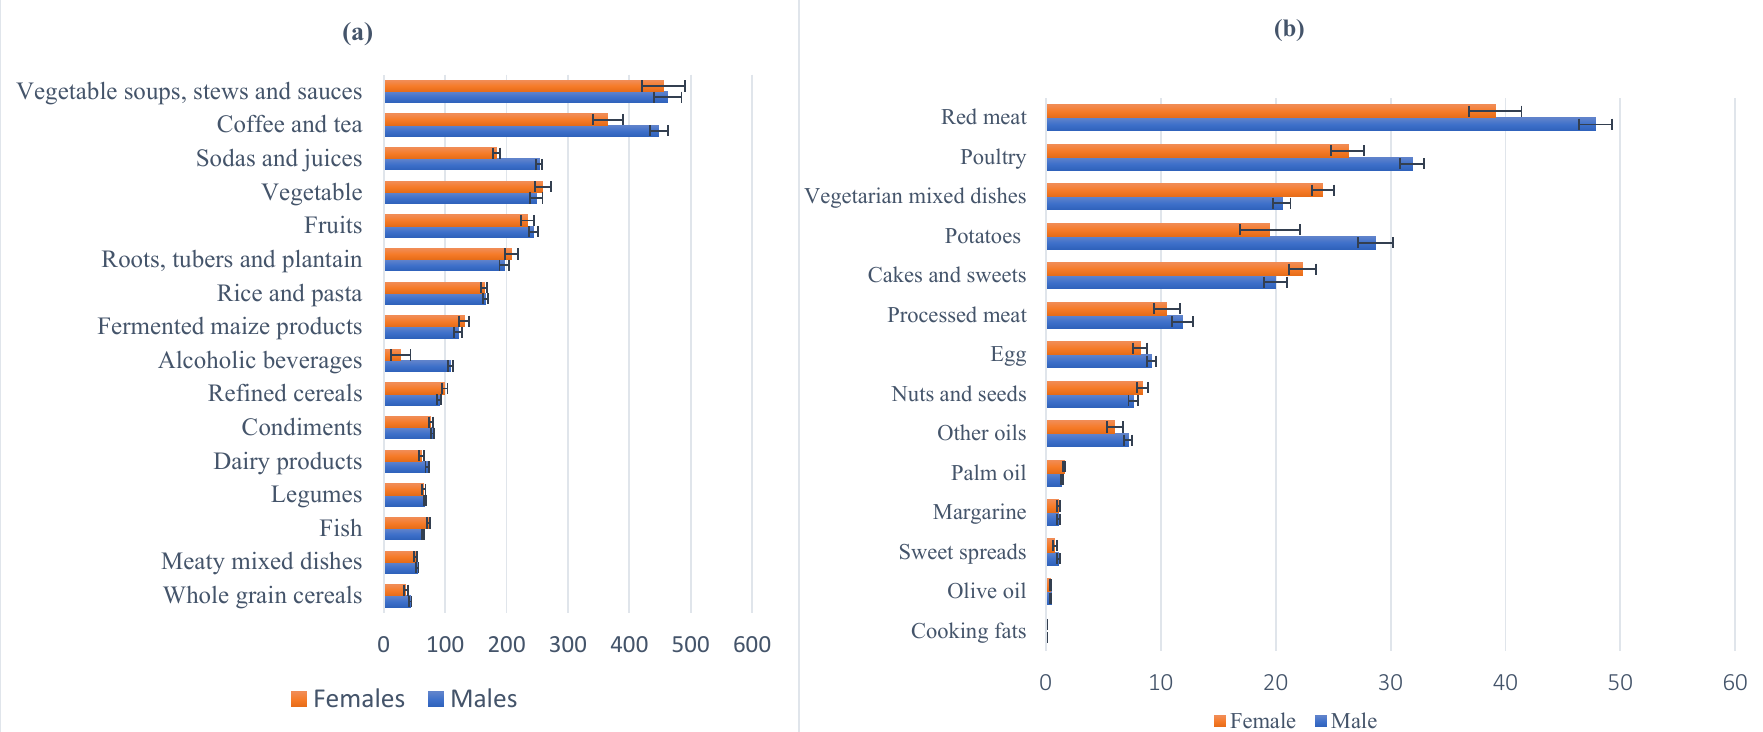
Figure 1. Mean intakes and standard deviations (g/day) of ( a ) 16 food groups with a mean intake of ˃ 50g/day and ( b ) 14 food groups with a mean intake of ≤ 50g/day.